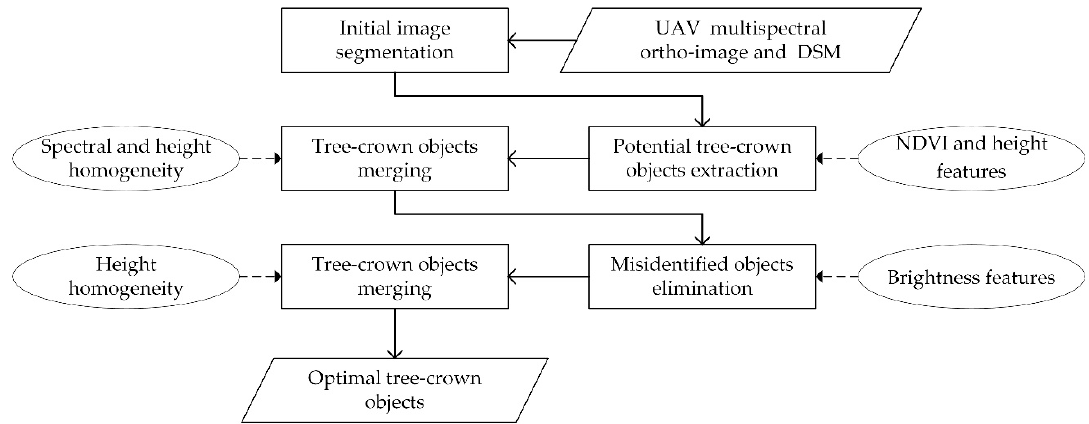
Figure 3. The process of tree-crown object extraction and features used in each step.